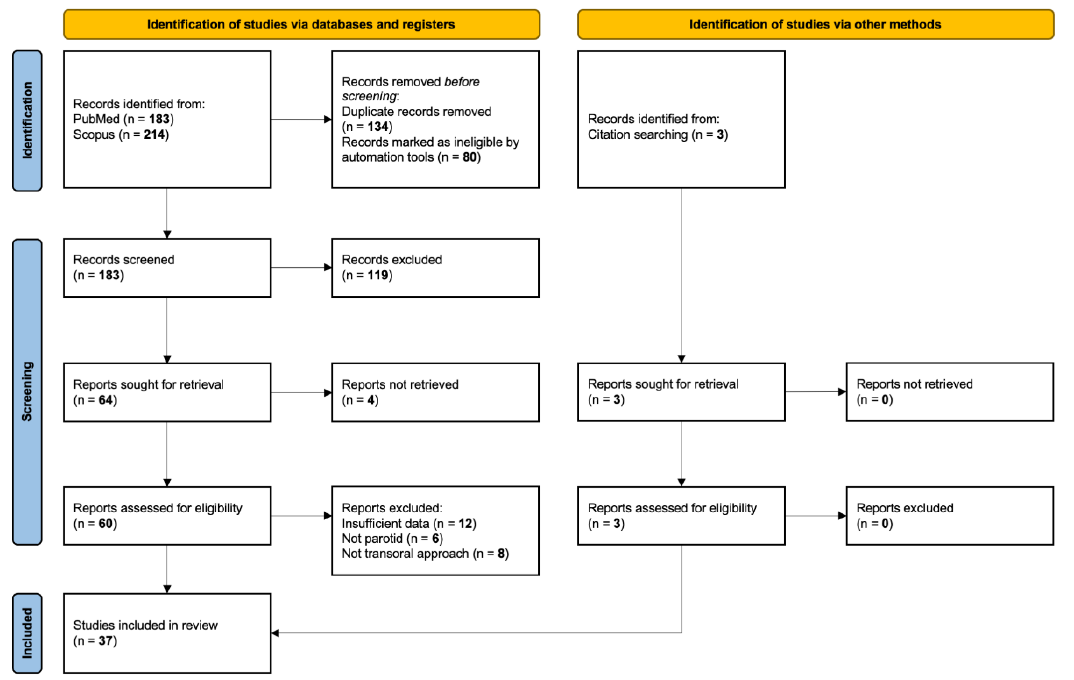
Figure 2. Review of the English literature through PubMed and Scopus, accessed on 30 October 2022. Primary search was performed using the terms “parotid AND transoral AND (tumor OR cancer OR adenoma OR Warthin)”.